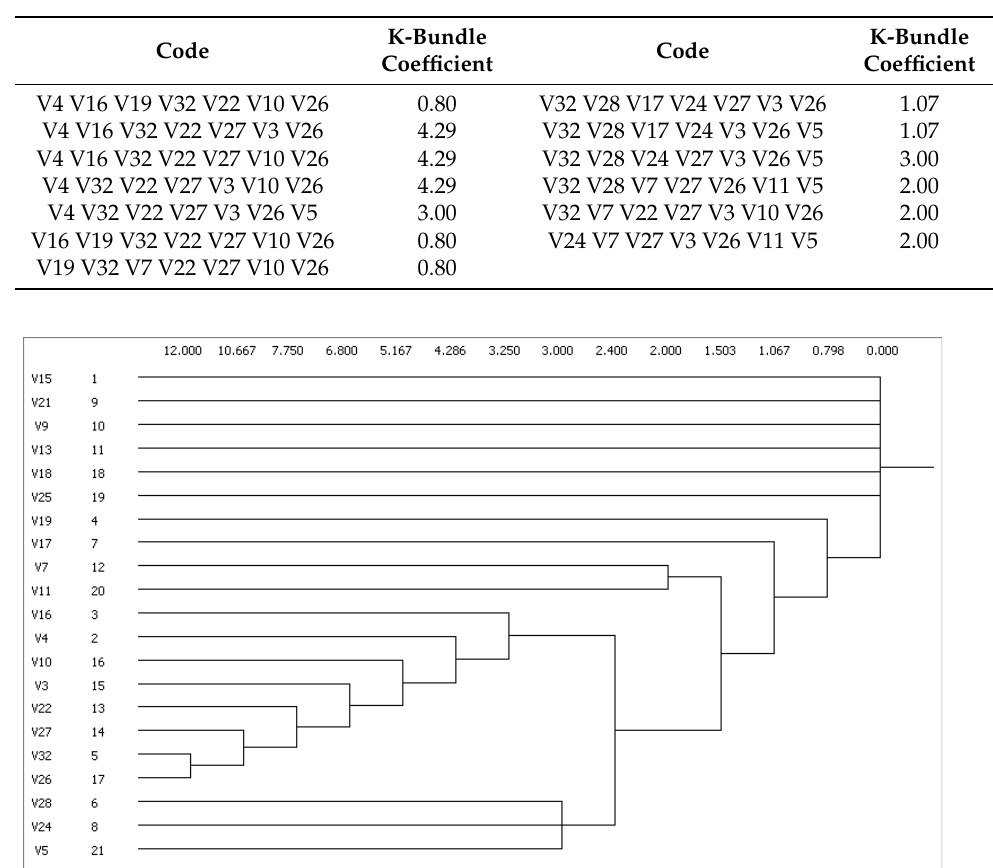
Figure 8. K-cluster analysis tree of the network.